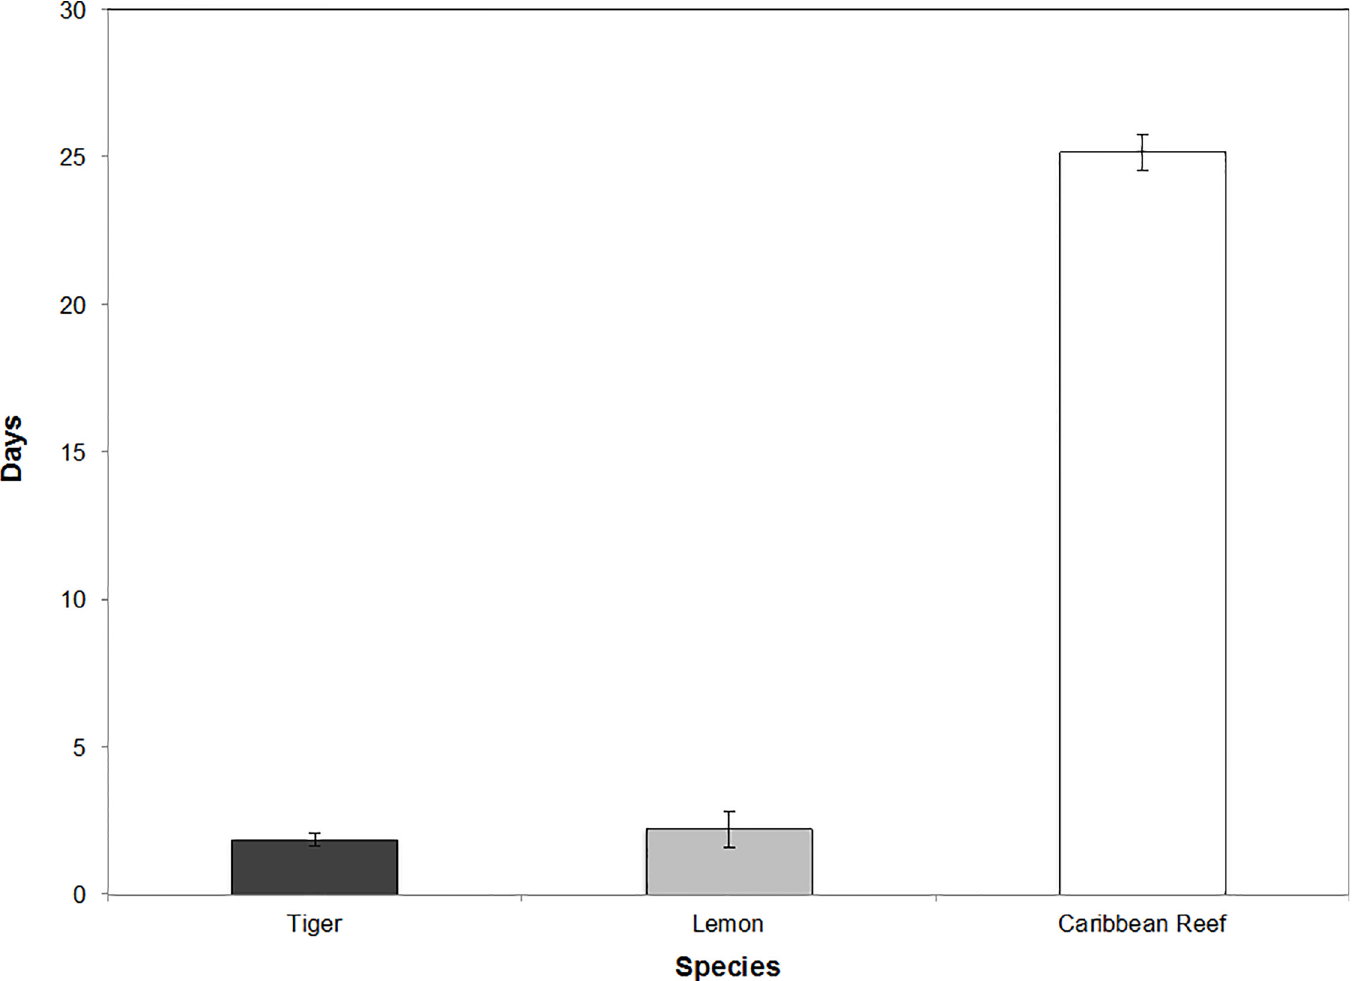
Fig 3. Average presence values for three species of shark within MCE habitat monitored by the acoustic array. Presence values (days) = average number of consecutive days detected on any receiver within the acoustic array for tiger (1.8), lemon (2.2), and Caribbean reef sharks (25.2). Bars represent means ± standard